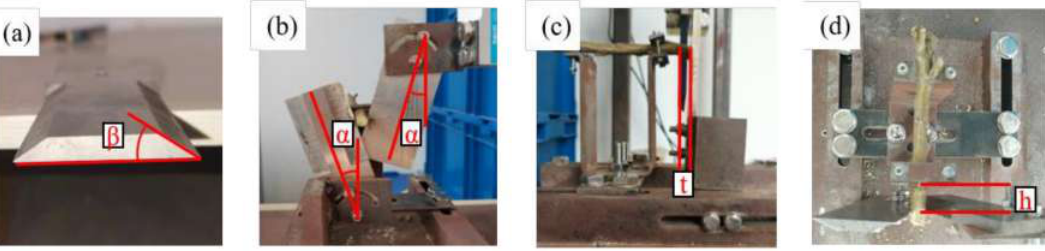
Figure 3. Tool parameters. ( a ) slip cutting angle. ( b ) wedge angle. ( c ) Cutting gap. ( d ) Cutting